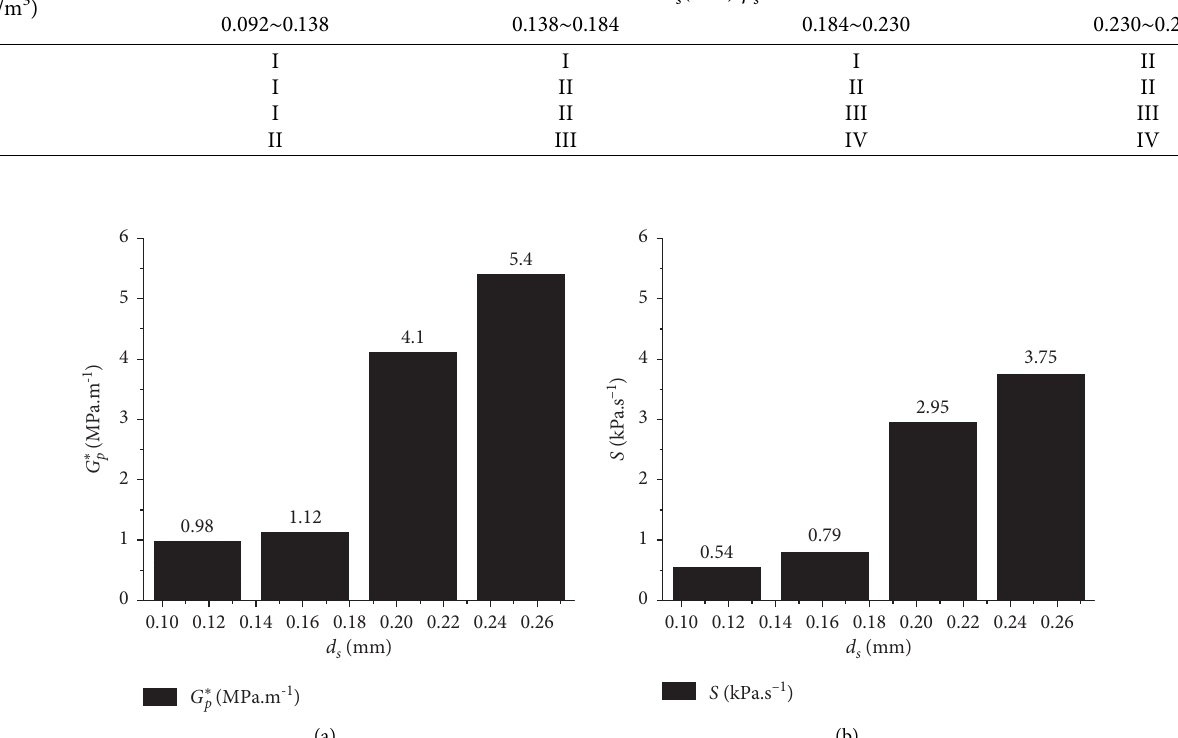
Figure 6: Hysteresis indicators of type IV hysteresis curves under different sand particle sizes at b � 0.5 mm and ρ � 80kg/m 3 . (a) Maximum hysteresis. (b) Hysteresis area.